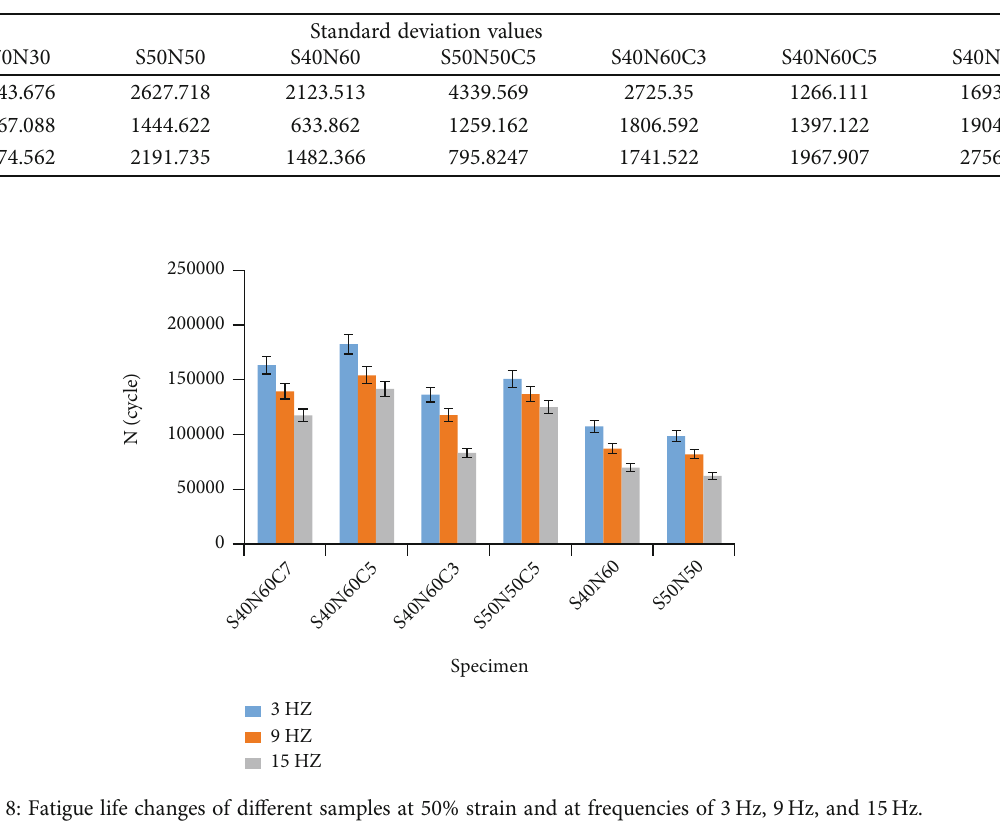
Table 5: Standard deviation values according to the fatigue life test of samples.